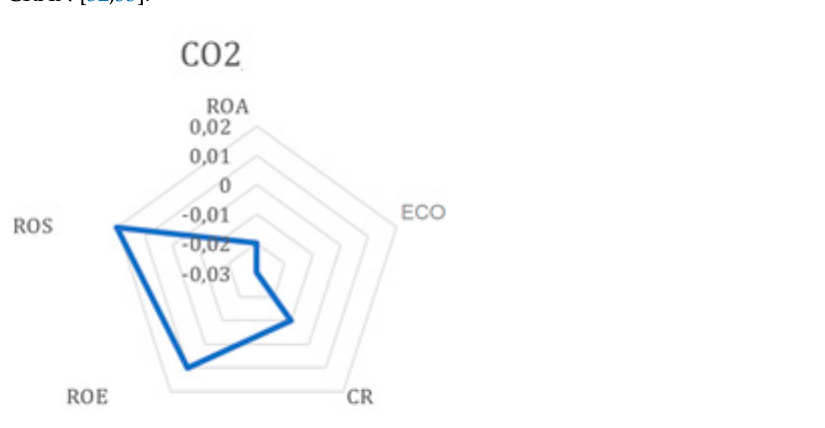
Figure 9. The degree of correlation of the greening index and financial indicators of LSPs in 2020.